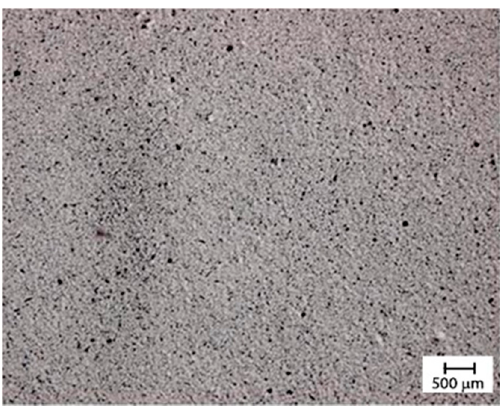
Figure 13. Optical microscopy of the dispersion obtained with the calendar with a distance between the rollers of 0.25 mm.